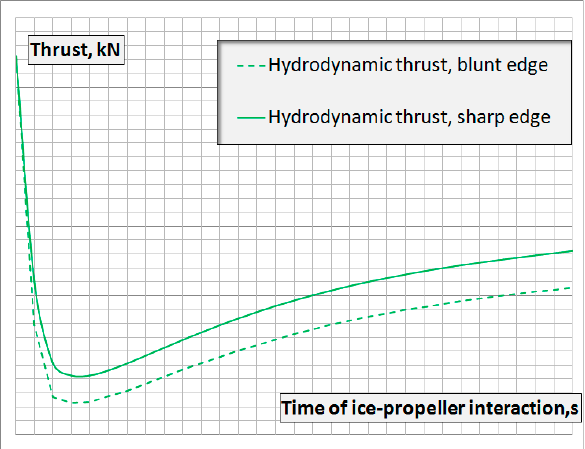
Figure 14. Hydrodynamic thrust variation during movement astern in ridges.